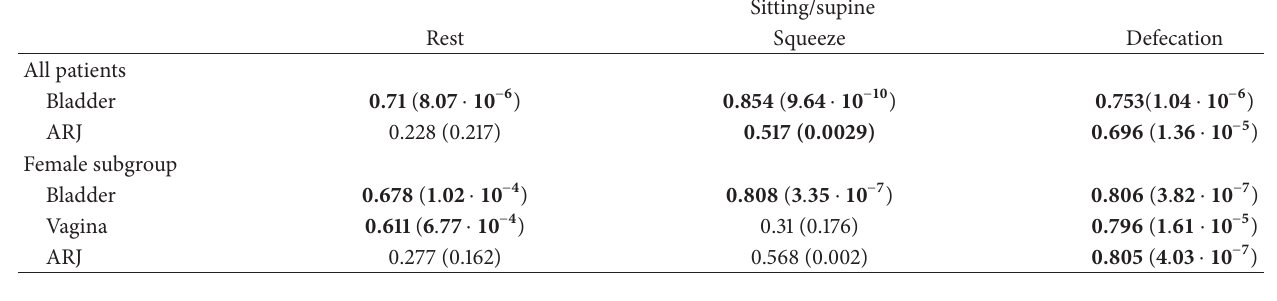
Table 3: Pearson’s test correlation coefficient and related 𝑝 value (in parentheses).